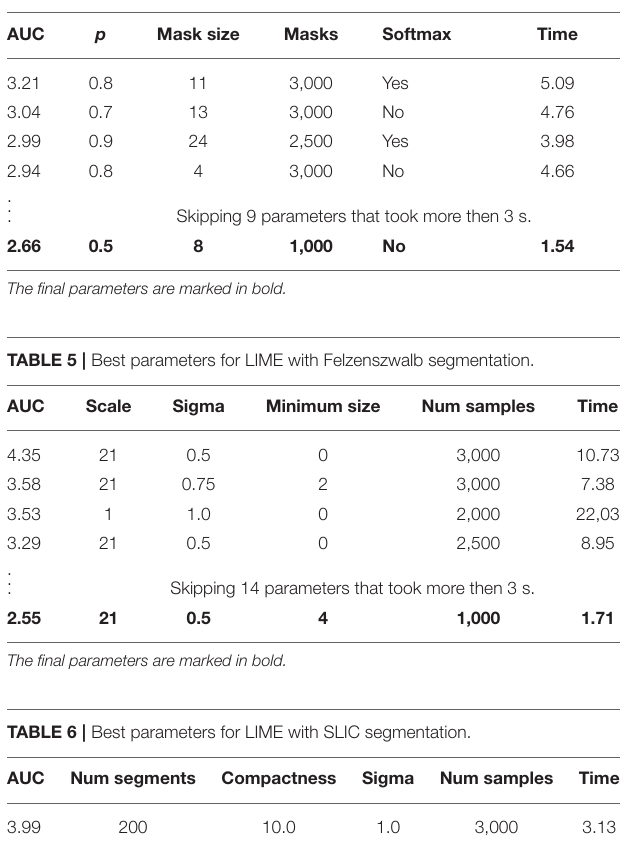
TABLE 4 | Best parameters for RISE.